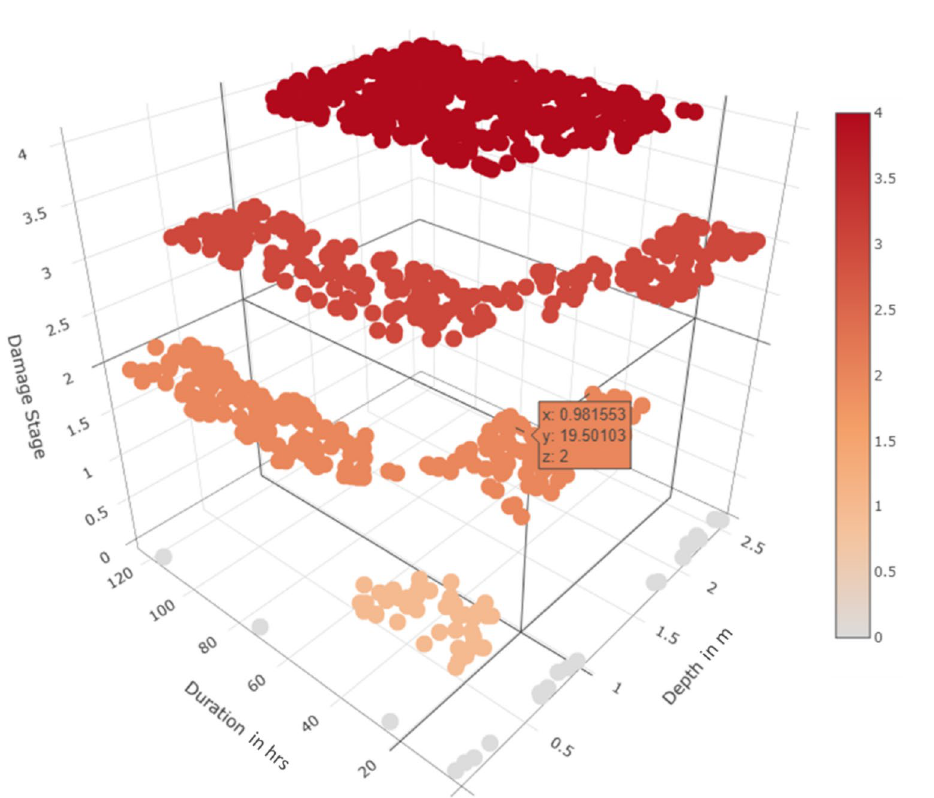
Figure 11. Damage stage for mud building based on the literature-based